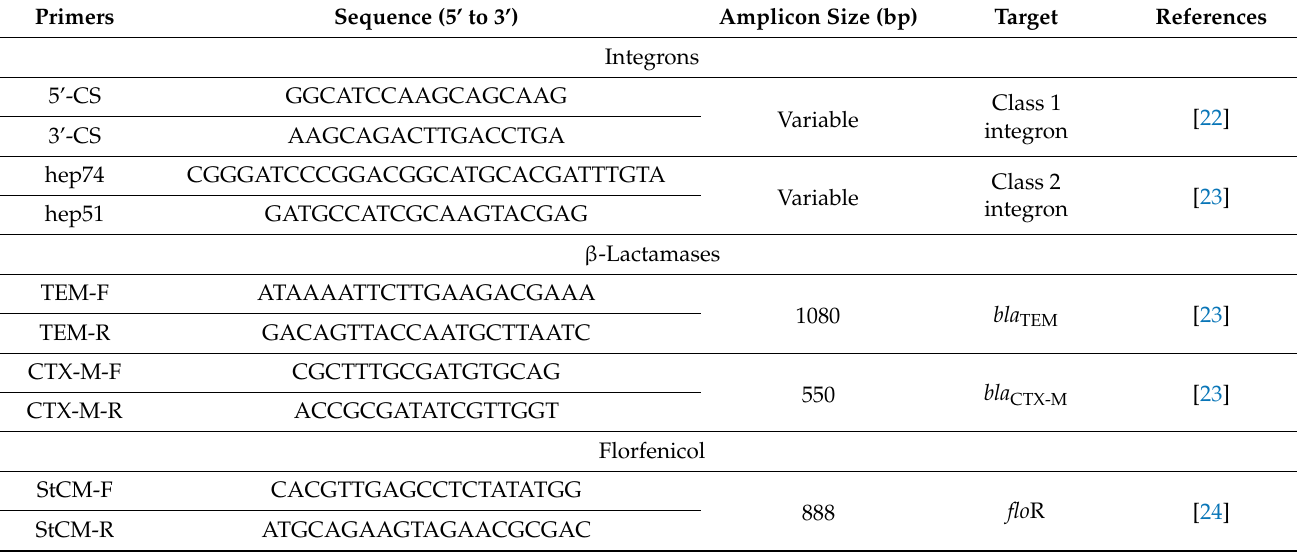
Table 1. Primer names, target genes, oligonucleotide sequences, and the product sizes used in PCR and DNA sequencing.